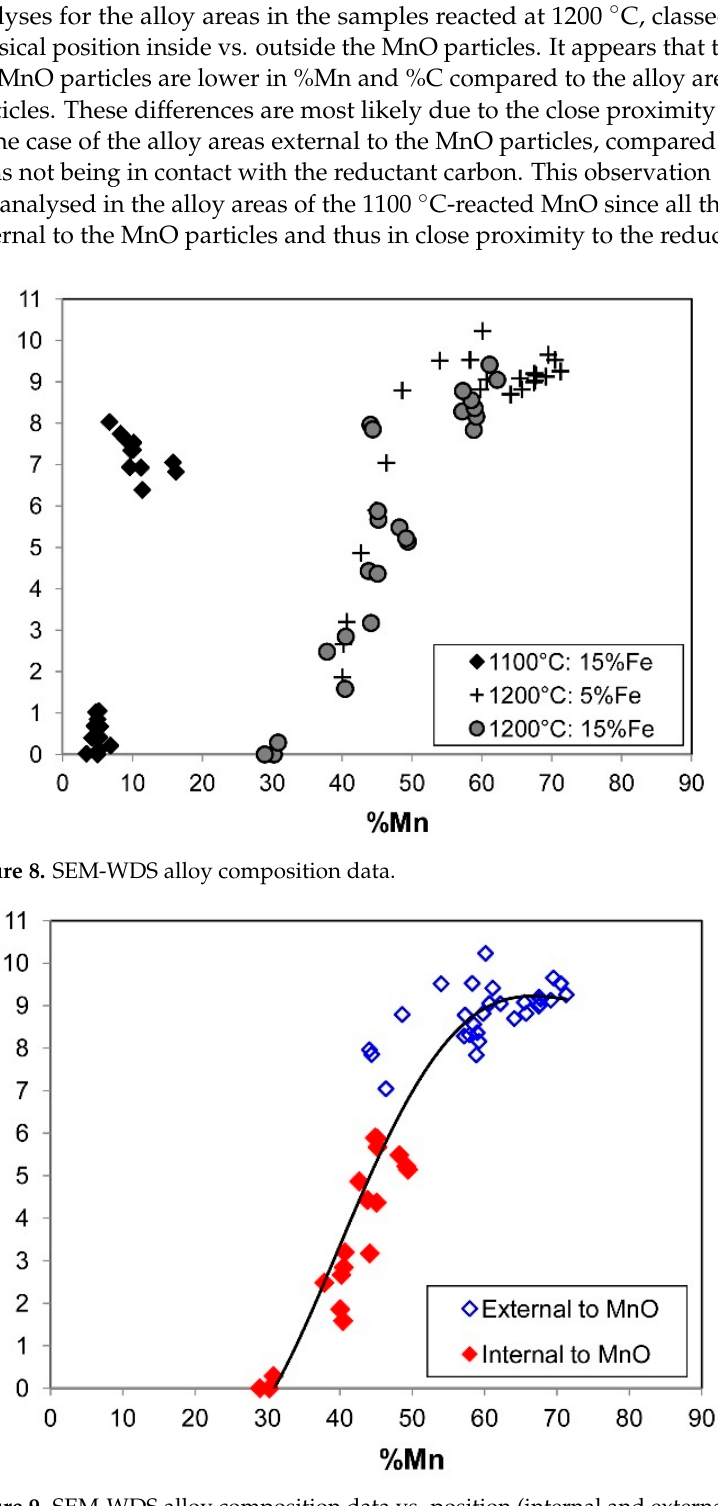
Figure 9. SEM-WDS alloy composition data vs. position (internal and external to MnO).